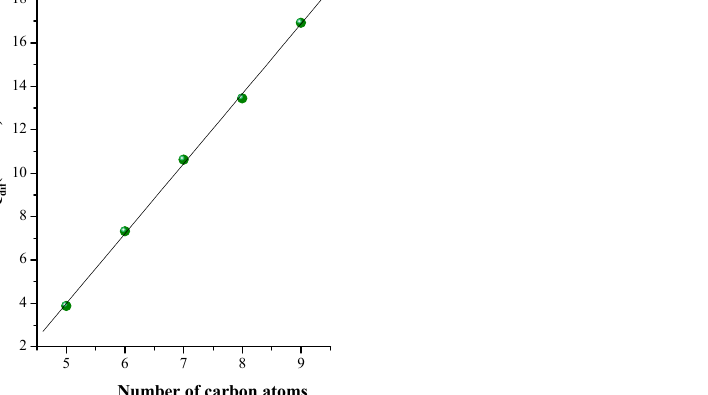
Figure 9. Dependence of differential adsorption heats (Q d ) on the number of carbon atoms C5–C9 in the n -paraffins.